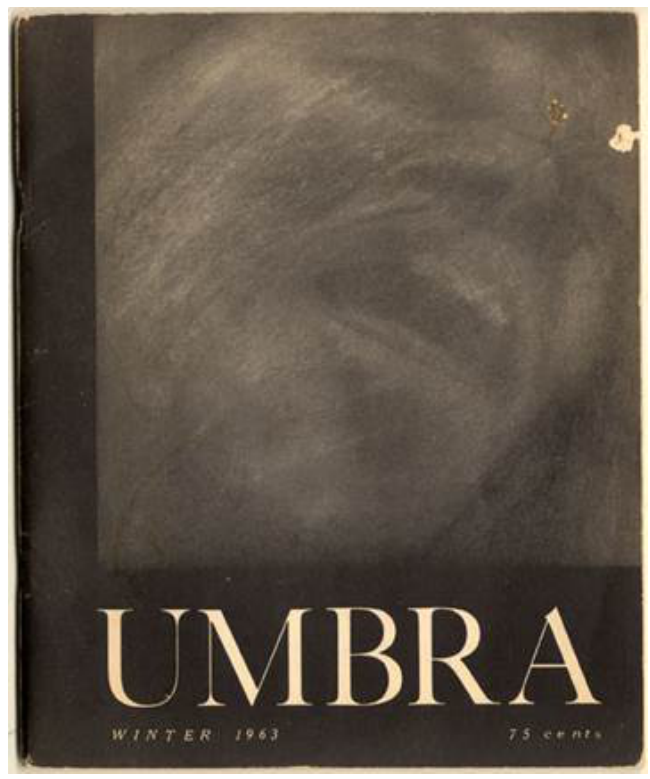
Figure 2 Cover of Umbra , (winter 1963). Unknown